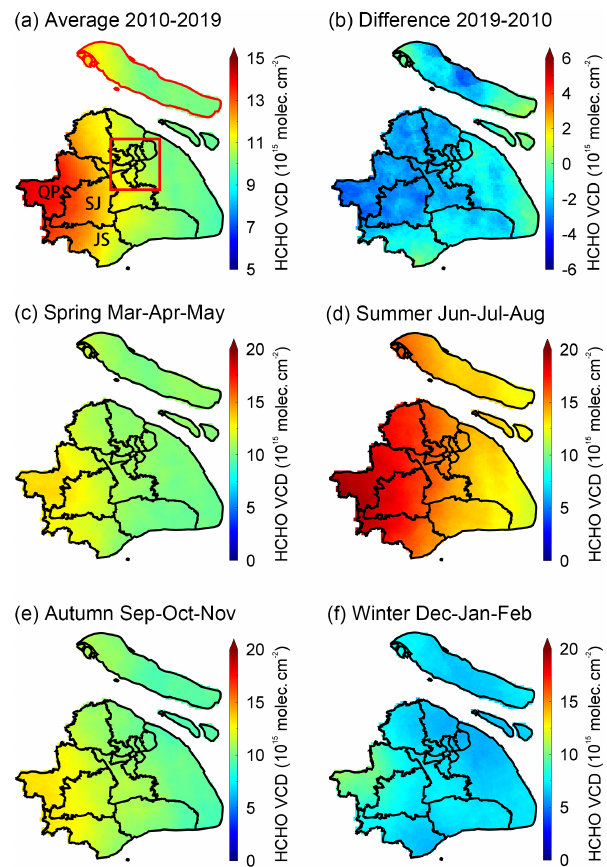
Figure 2. Spatial distribution of HCHO VCDs in Shanghai: (a) av- erage HCHO VCD for 10 years, (b) the difference of HCHO VCDs between 2019 and 2010 (2019 minus 2010), and (c–f) for different seasons. In (a) the city center is marked with a red box; Chong- ming Island is displayed with a red boundary. QP, SJ, and JS refer to Qingpu, Songjiang, and Jinshan